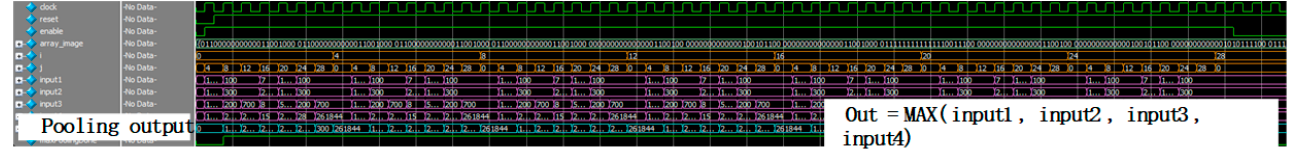
Figure 18. The simulation result of the max-pooling operation.